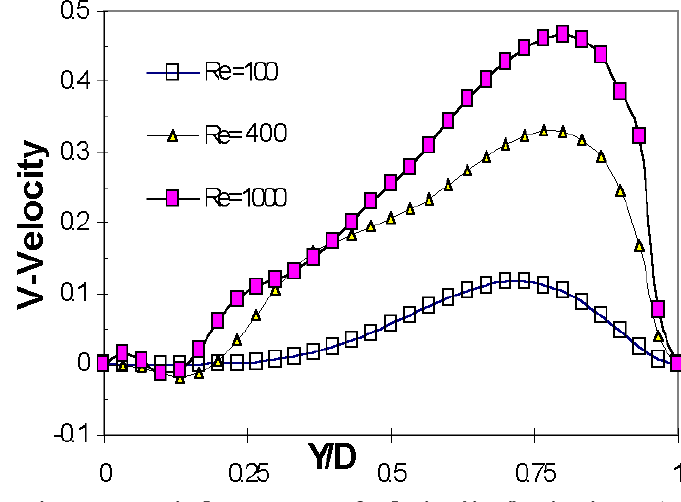
Figure 7. Vertical component of velocity distribution in x=1/2